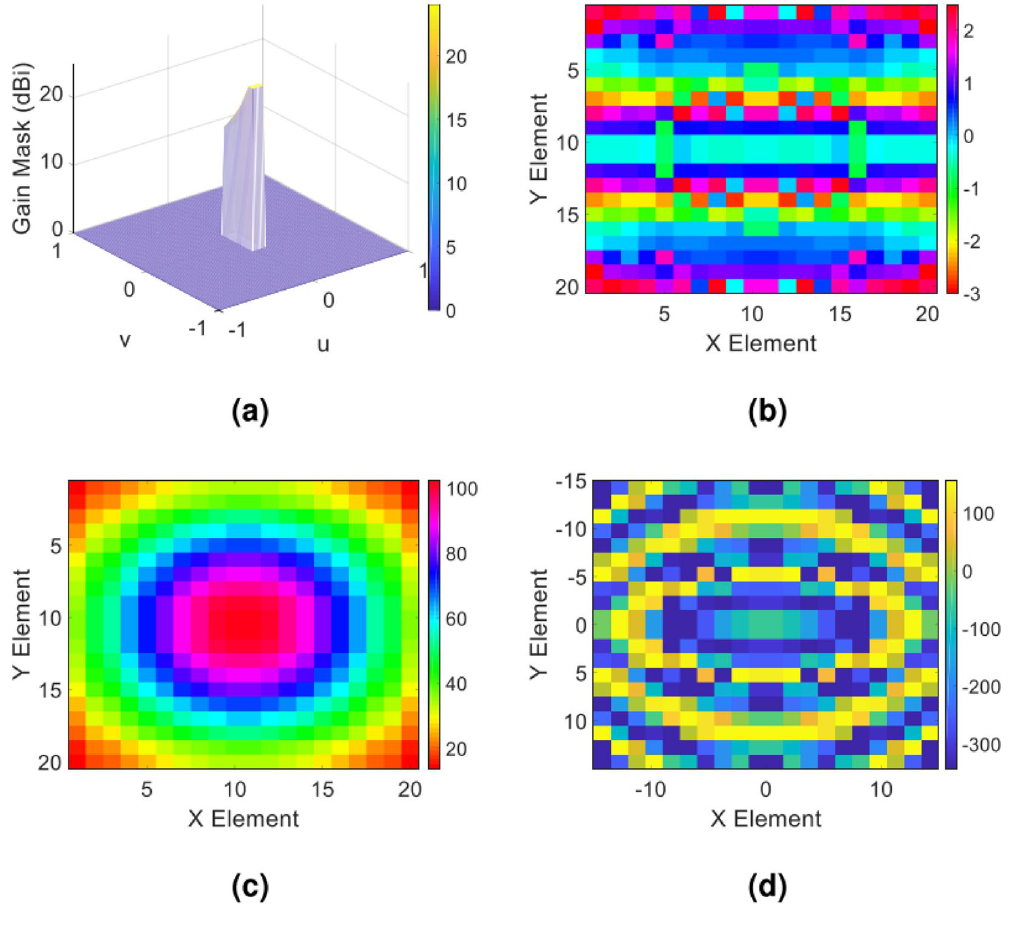
Figure 9. ( a ) The expected object wave in the (u, v) plane; ( b ) the phase and ( c ) amplitude of overall tangential electric field in the hologram plane; ( d ) the impedance distribution of the hologram obtained from the Eq.